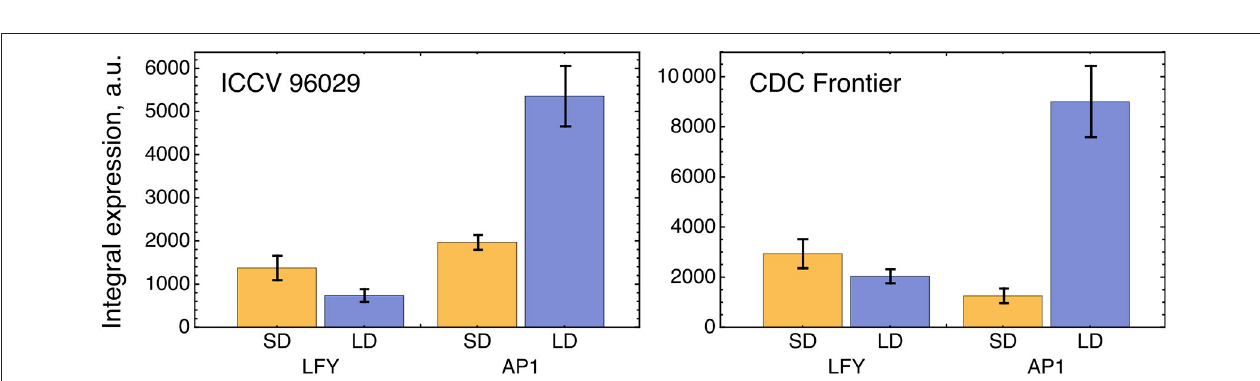
FIGURE 3 | Integral expression levels of LFY and AP1 under two growth conditions in two cultivars, based on the data from (Ridge et al., 2017). At each time where data was available, 100 expression values were sampled from the normal distribution with the mean and s.d. presented at this temporal point in the data. These values then were interpolated across time, producing a set of 100 expression dynamics, and these dynamics were integrated over time. The chart and error bars show means and standard deviations, respectively, over this set of the integral values.